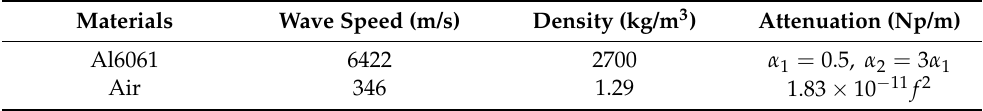
Table 1. Acoustic parameters of the two-layered medium used in the wave field calculation.